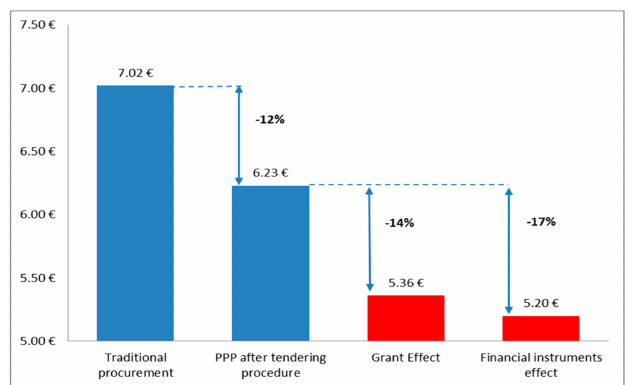
Figure 7. Value-for-Money analysis with grant and financial instrument e ff ect. Source: Authors’ calculation.